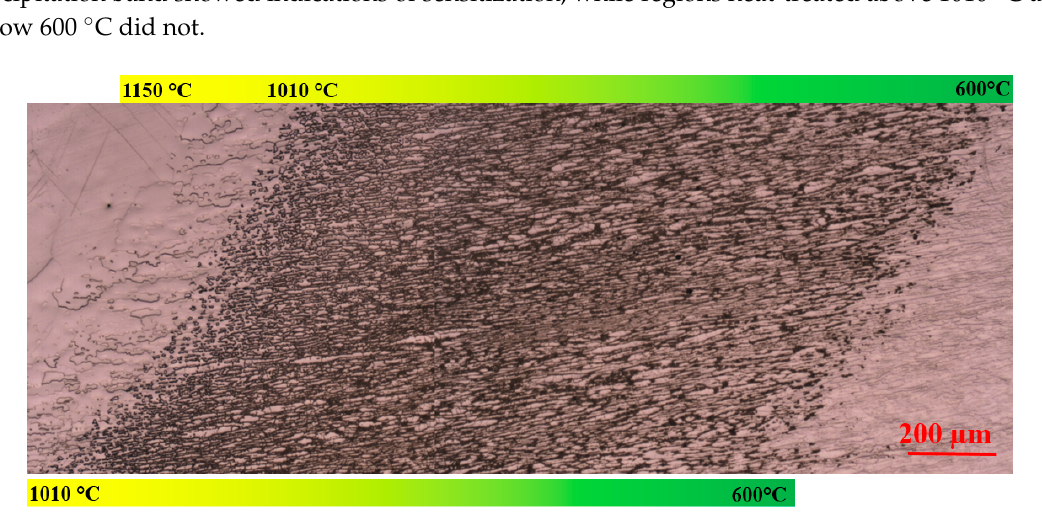
Figure 11. Optical micrograph of cross-section after sensitization screening test by 10% oxalic acid showing sensitization in the σ -containing region. Heat treatment temperatures are shown with color bars.